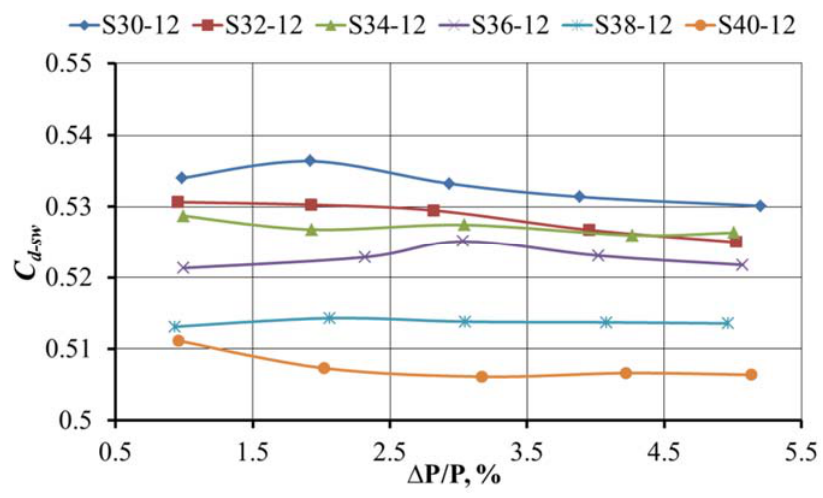
Figure 5. The effect of swirl angle on discharge coefficient of swirler.